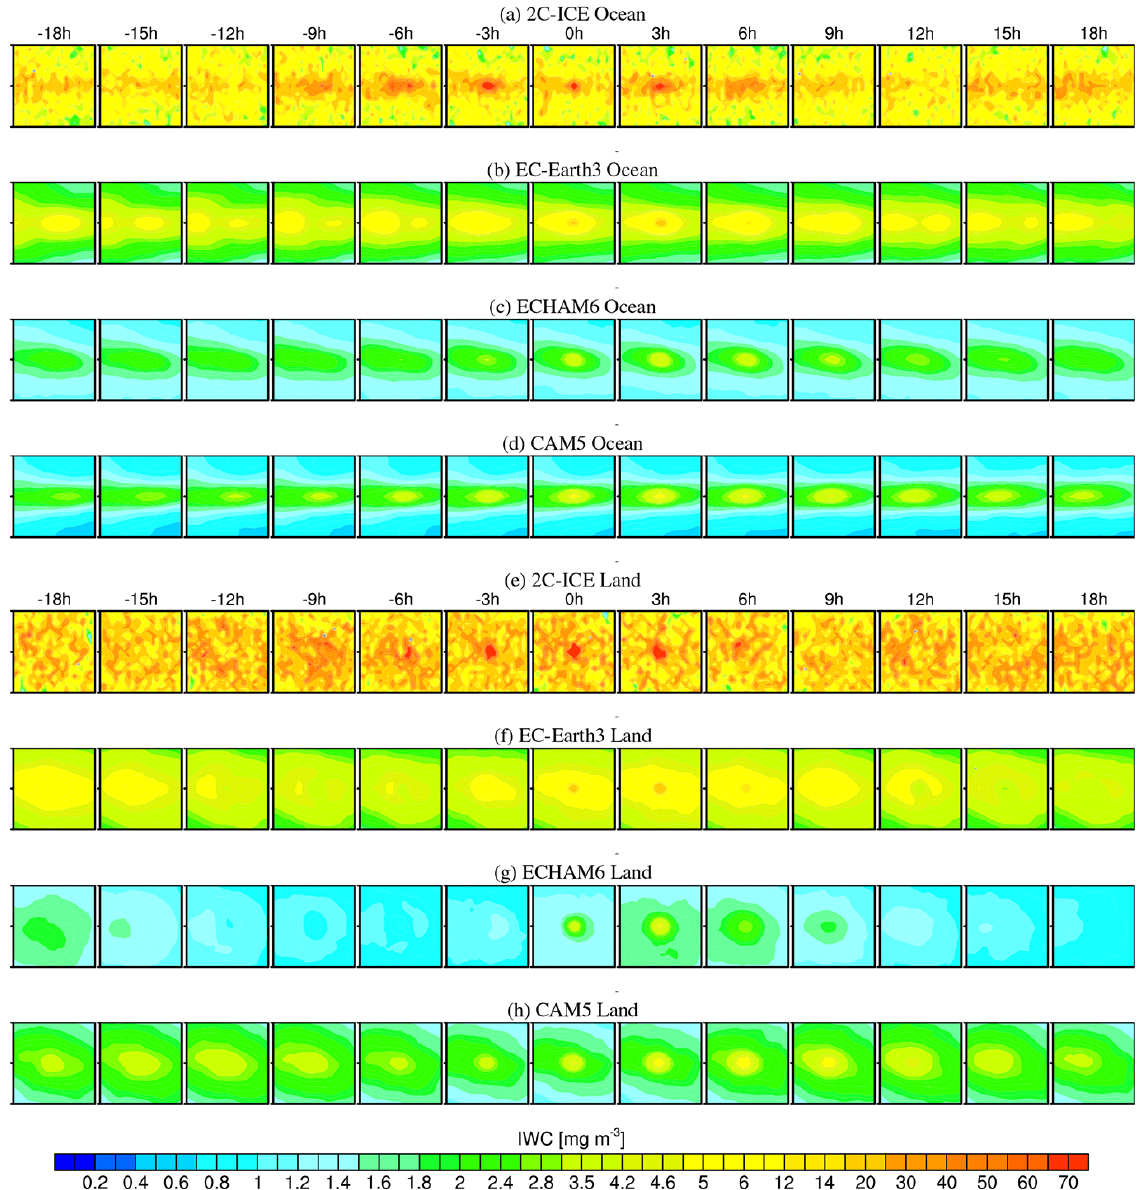
Figure 8. Composite of ice water content (IWC) at 200 hPa for ocean-based (a–d) and land-based (e–h) systems for 2C-ICE followed by the models. The spatio-temporal coverage of ± 18h at every 3h interval and ± 10 ◦ longitude and latitude is taken from the centre point and graduated every ± 1 ◦